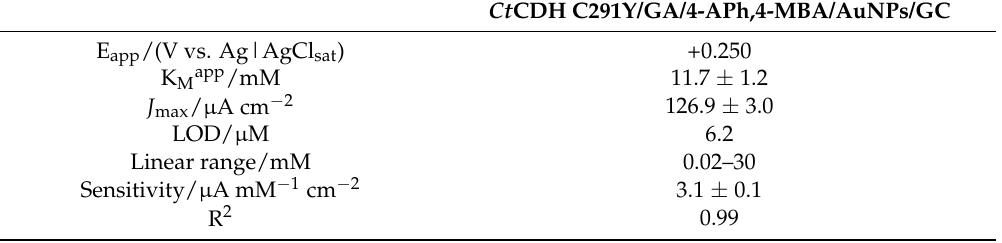
Table 2. Electroanalytical and kinetic parameters of the Ct CDH C291Y/GA/4-APh,4-MBA/AuNPs/GC biosensor obtained by FIA amperometry in 50 mM TRIS buffer, pH 7.4. Applied potential: +0.250 V vs. Ag|AgCl sat